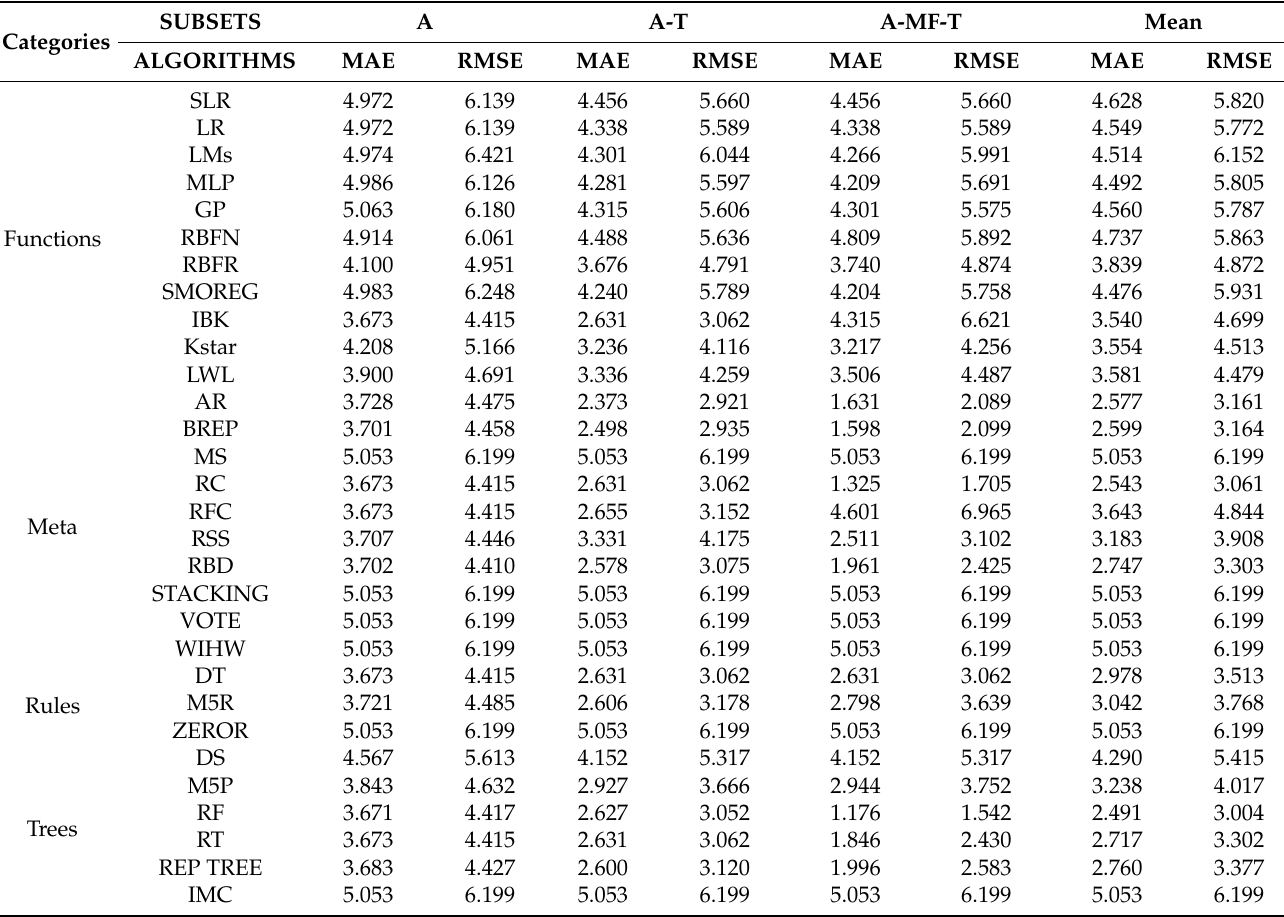
Table 8. Selection of the best performances from the different